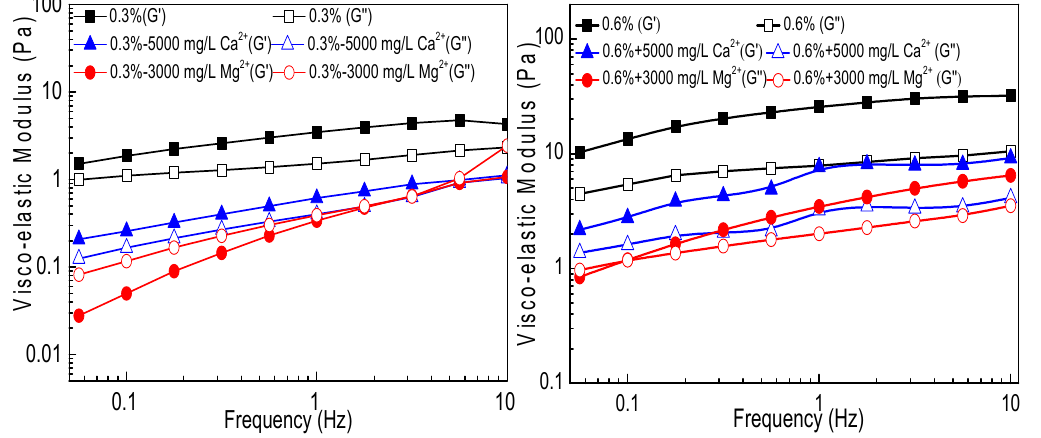
Figure 15. Viscoelasticity of a DiPHAM under the condition of high salinity.